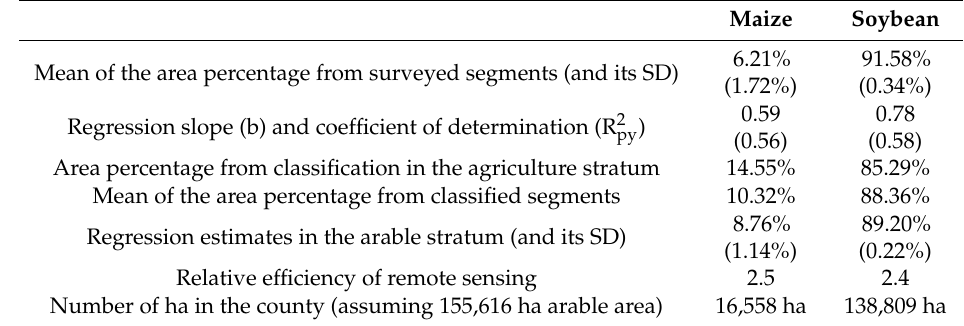
Maize Soybean 6.21% 91.58% (1.72%) (0.34%) 0.59 0.78 (0.56) (0.58) 8.76% 89.20% (1.14%) (0.22%)